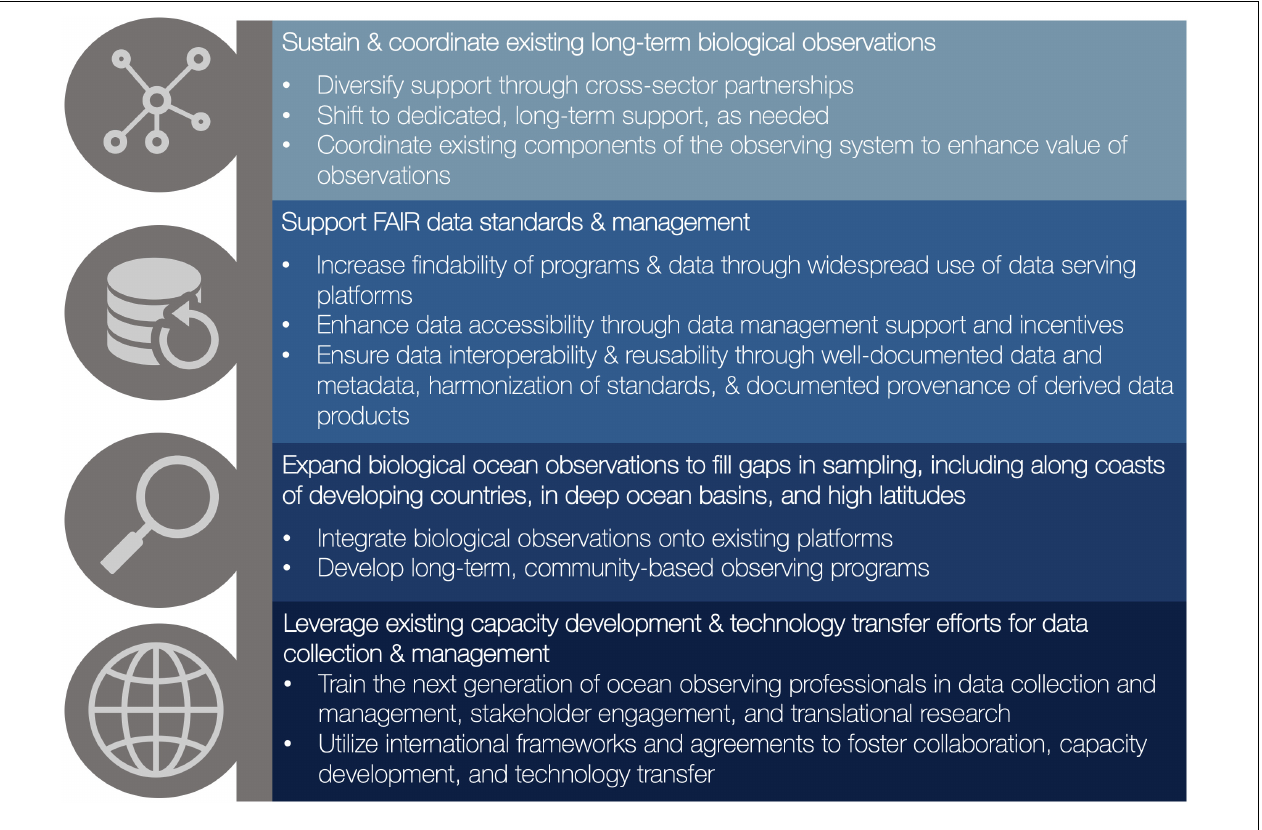
FIGURE 7 | Possible future directions for a sustained, coordinated biological ocean observing system based on the results of this